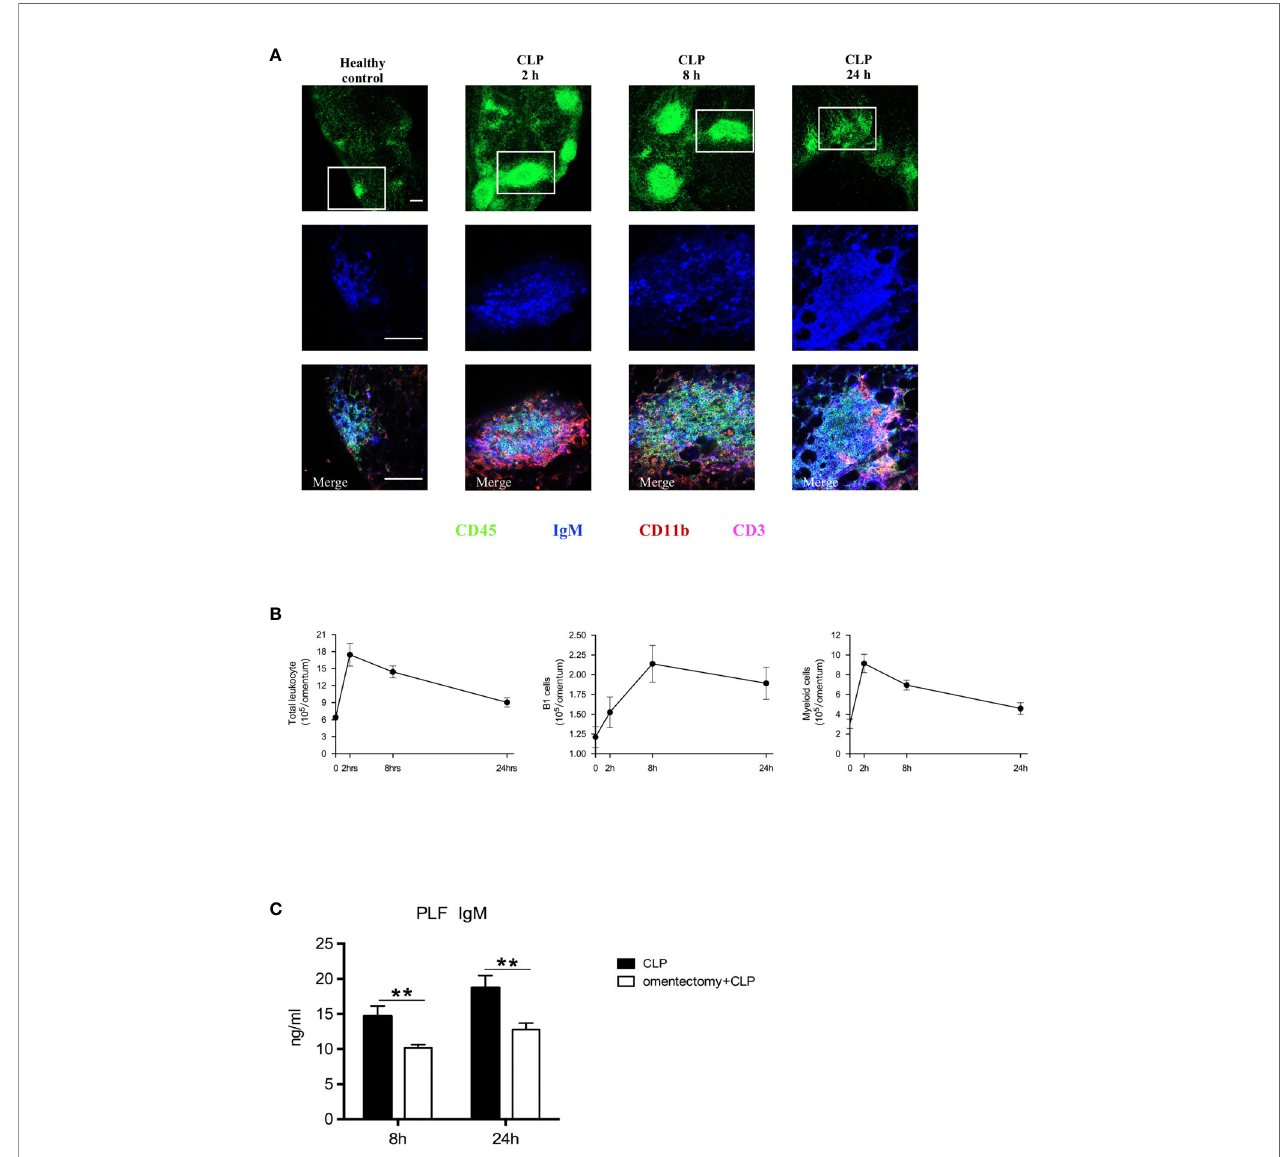
FIGURE 3 | Omental MSs and B cells are elicited in response to peritoneal infections. (A) Whole-mount immuno fl uorescence staining of the omentum allowing visualization of MSs with CD45 + staining (green)on the top row, B1 cells with IgM + staining (blue) on the middle row and myeloid cells with CD11b + staining (red), B1 cells with IgM + staining (blue), and T cells with CD3 + staining(pink) on the bottom row respectively at indicated time intervals after CLP. Pictures are representative of 6 mice for each condition. The scale bar is 200 m m. (B) At the indicated intervals after CLP, fl ow cytometric analysis of digested omental cells from healthy controls or CLP mice (n = 6 per group) at indicated time intervals were performed and the numbers of total leukocytes, B1 cells, Myeloid cells were counted. All values are shown as means ± SEM. (C) At indicated intervals after CLP, PLF samples were collected and IgM concentrations were determined by ELISA. All values are shown as means ± SEM. ** p < 0.01 for omentectomized vs